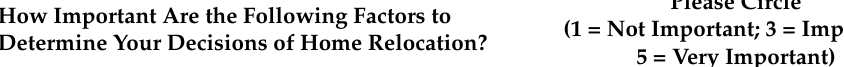
Table 2. The 5-point Likert scale questions for ranking the major factors determining relocation